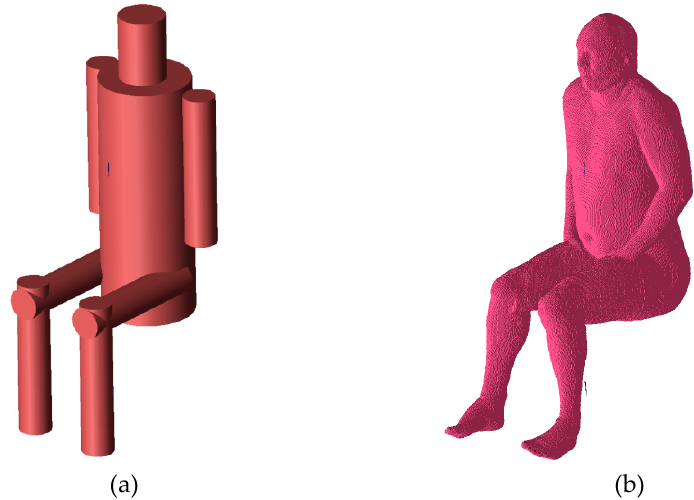
Figure 5. The human body models: ( a ) simplified-cylindrical; ( b ) anthropomorphic (multitissue).